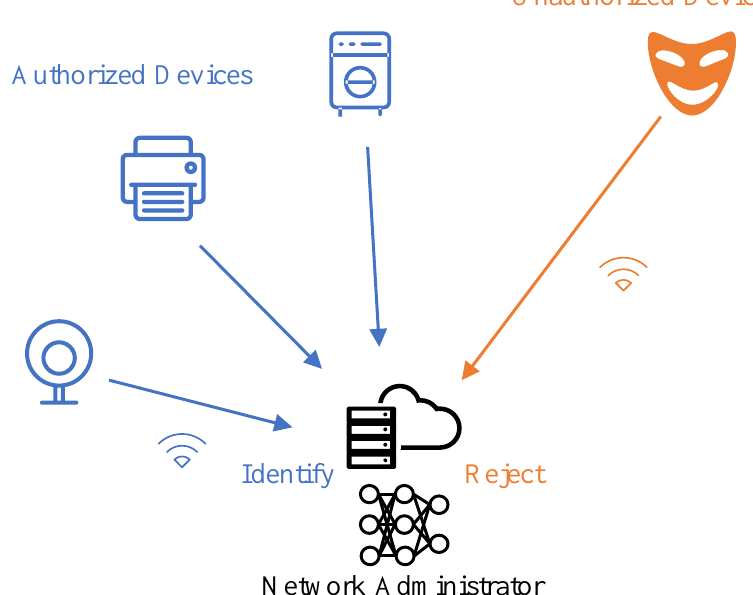
Figure 1. An example of device identification in the